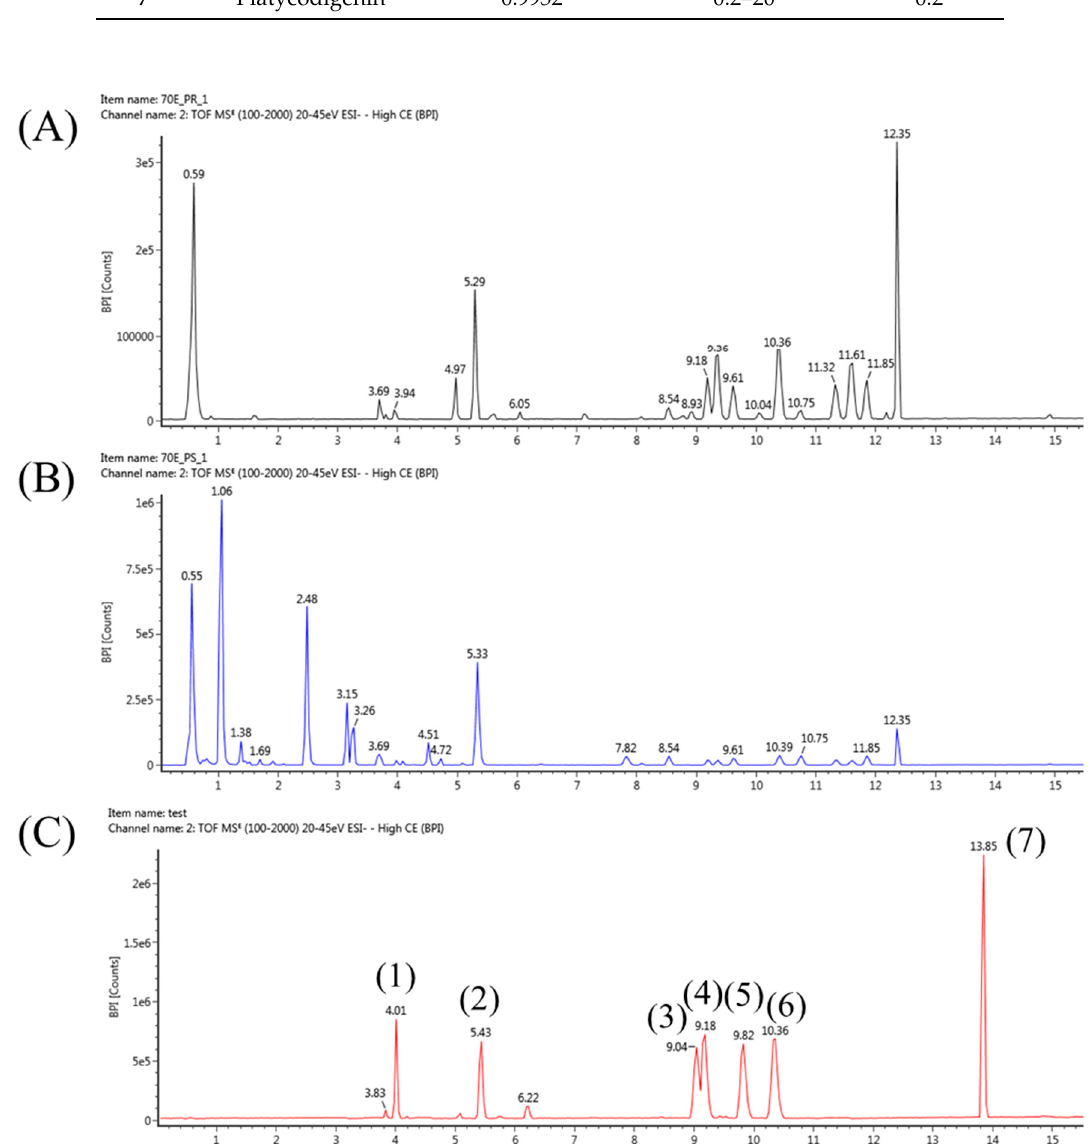
Figure 1. UPLC-QTOF/MS, ESI- base peak intensity (BPI) chromatogram of ( A ) P. grandiflorum roots, ( B ) P. grandiflorum stems and leaves and ( C ) seven standards, including (1) platycoside E, (2) platycodin D3, (3) platycodin D2, (4) platycodin D, (5) polygalacin D, (6) platycogenic acid A and (7) platycodigenin.